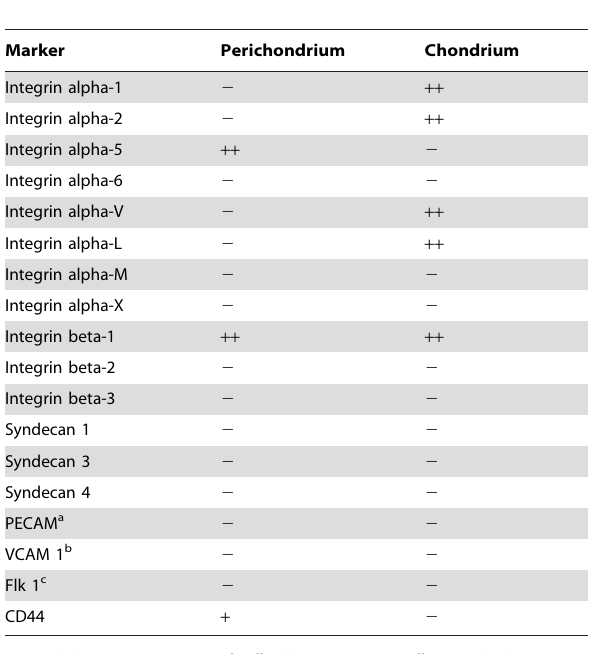
Figure 4. Localization of long-term LRCs in different parts of the external ear. (A) A few LRCs were present in the perichondrium in the distal and middle areas of the external ear (White arrowheads). Many LRCs were present in the opening of the external acoustic meatus (White arrowheads). Two-headed arrows: Chondrium. Scale bar=50 m m. Original magnification: 6 40 (Alcian blue staining), 6 100 (BrdU staining). (B) The LRCs of the distal and middle areas of the external ear and in the opening of the external acoustic meatus. The LRCs in the opening of the external acoustic meatus was much higher than that of the distal and middle areas (N=6). doi:10.1371/journal.pone.0026393.g004 Table 1. Cell surface marker characterization of chondrium and perichondirum layer using 24-week-old mice